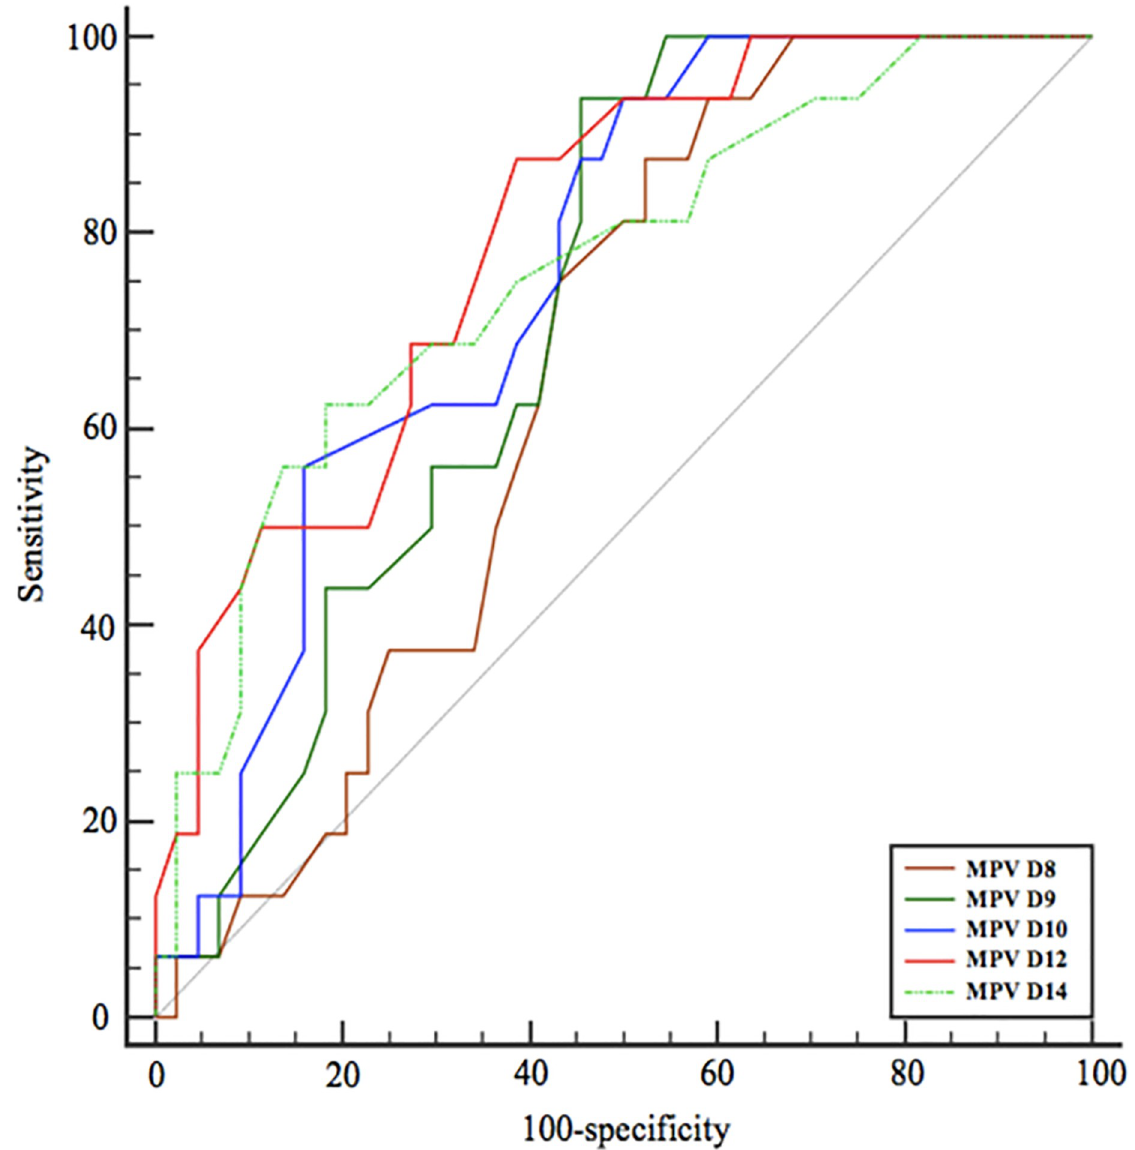
Fig 4. Comparison of areas under ROC curves according to Mean Platelet